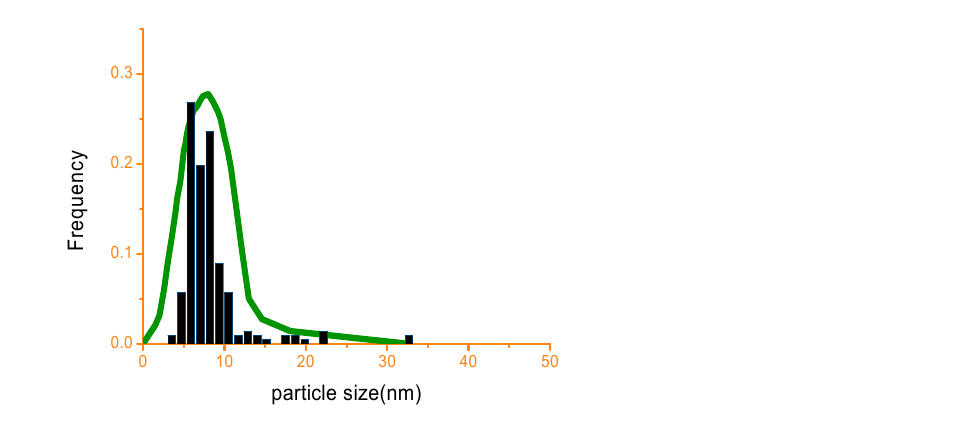
Figure 8. Comparison of predicted nanoparticle size distribution (PSD) with published experimental data (filled box [ ] represents experimental data and solid line [ ] represents simu- lation data).